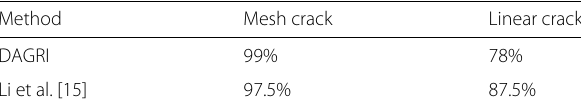
Table 3 Type of classification error